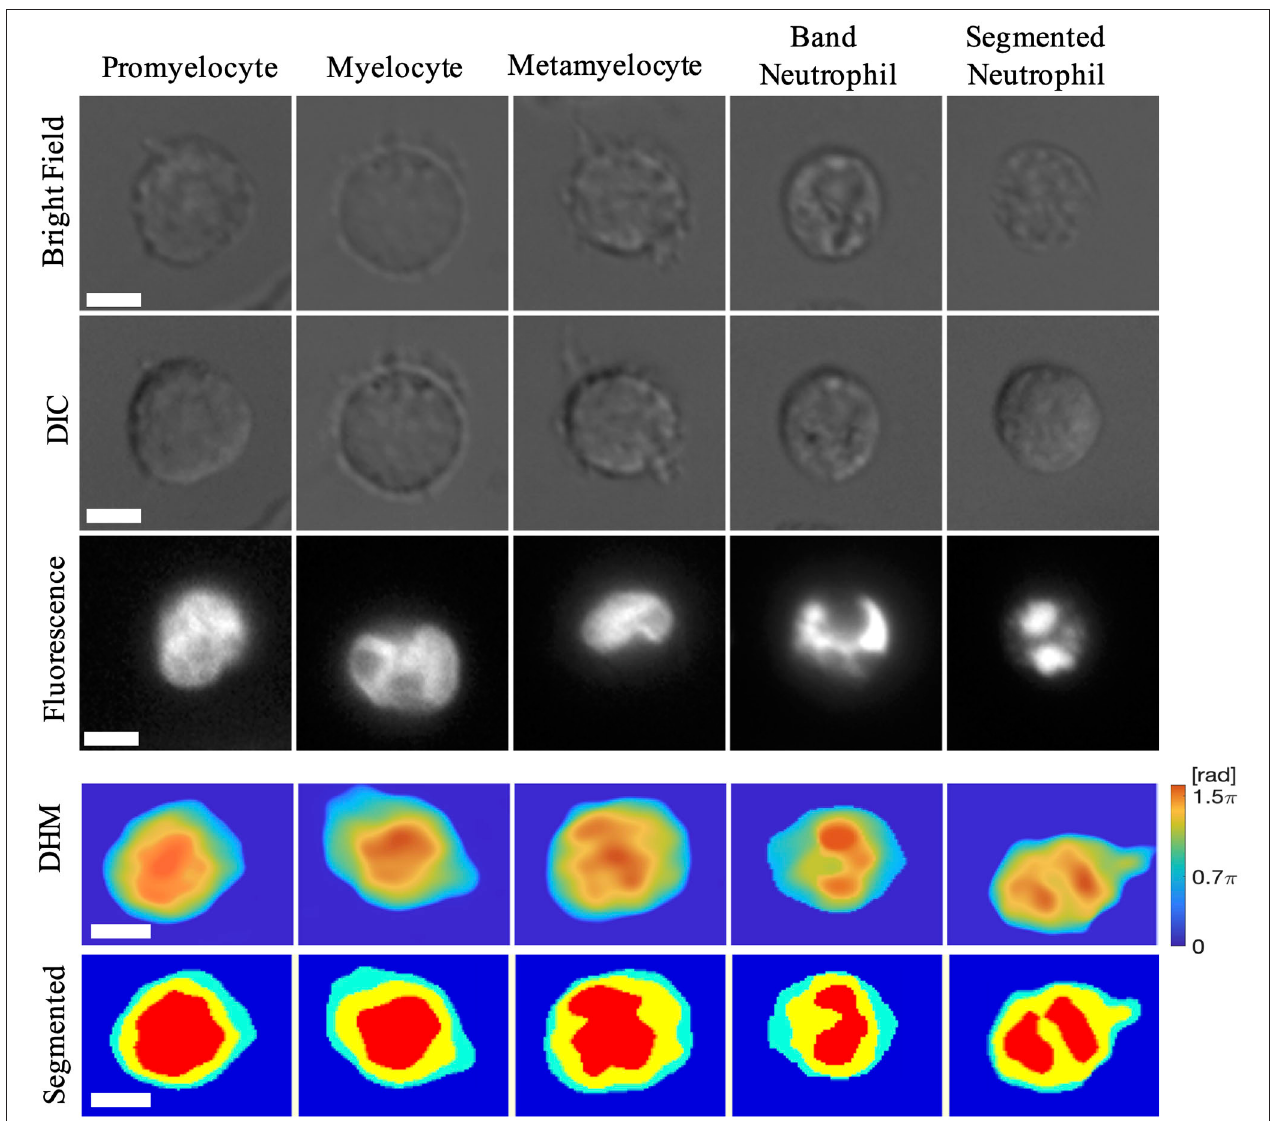
FIGURE 2 | Example of cells in different maturation stages. The first three rows show brightfield, DIC, and fluorescence images, where each column representing the same cell. The last two rows show the reconstructed OP difference (OPD) and cell segmentation. Scale bar: 5 µ m .